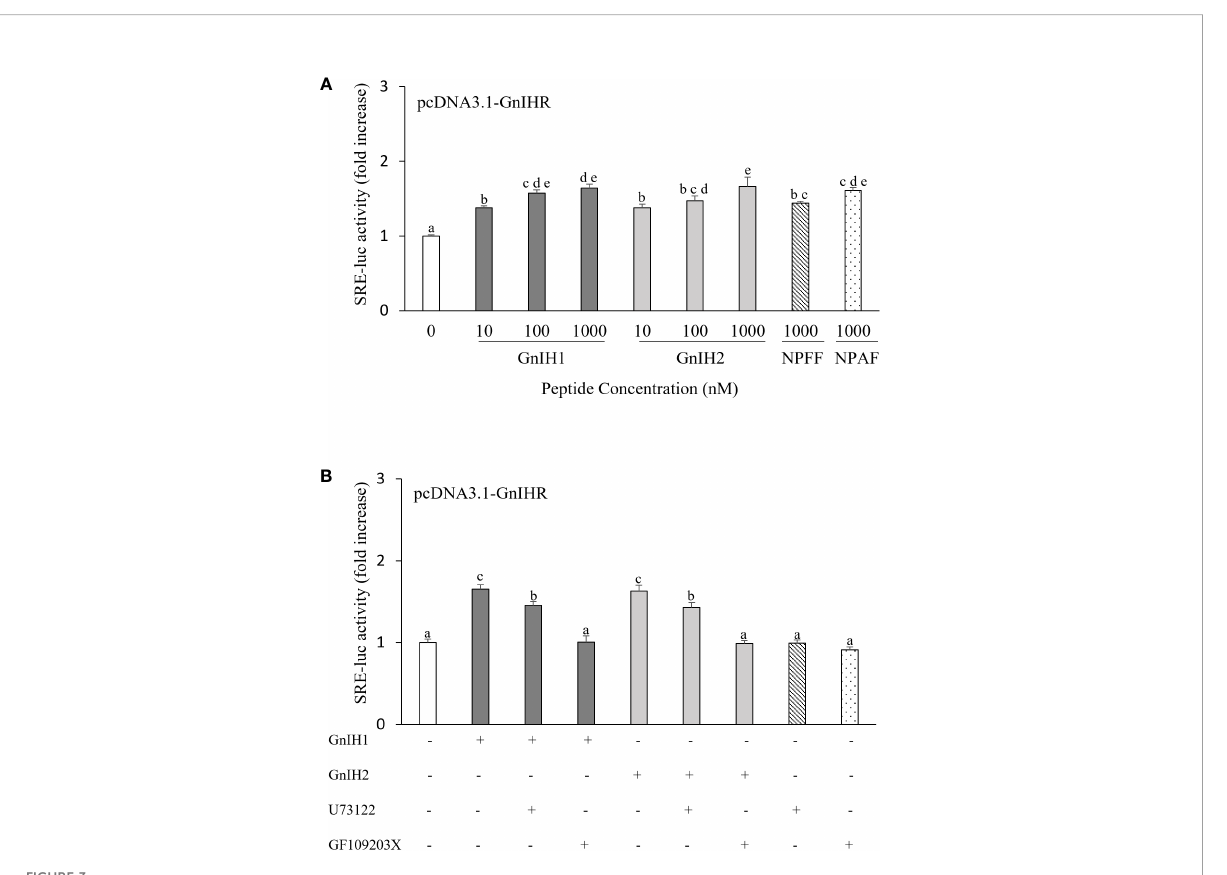
FIGURE 3 Effects of GnIH and NPFF peptides on SRE-luc activity in COS-7 cells transfected with sea bass GnIHR. Cells were challenged with GnIH and NPFF peptides alone (A) or co-incubated with GnIH peptides (1 m M) in the absence/presence of 10 m M PLC inhibitor U73122 (B) and 10 m M PKC inhibitor GF109203X (B) for 6 h and then harvested for assays. Data are presented as the mean ± SEM (n=6-9). Different letters indicate statistically signi fi cant differences between mean values (ANOVA one-way p <